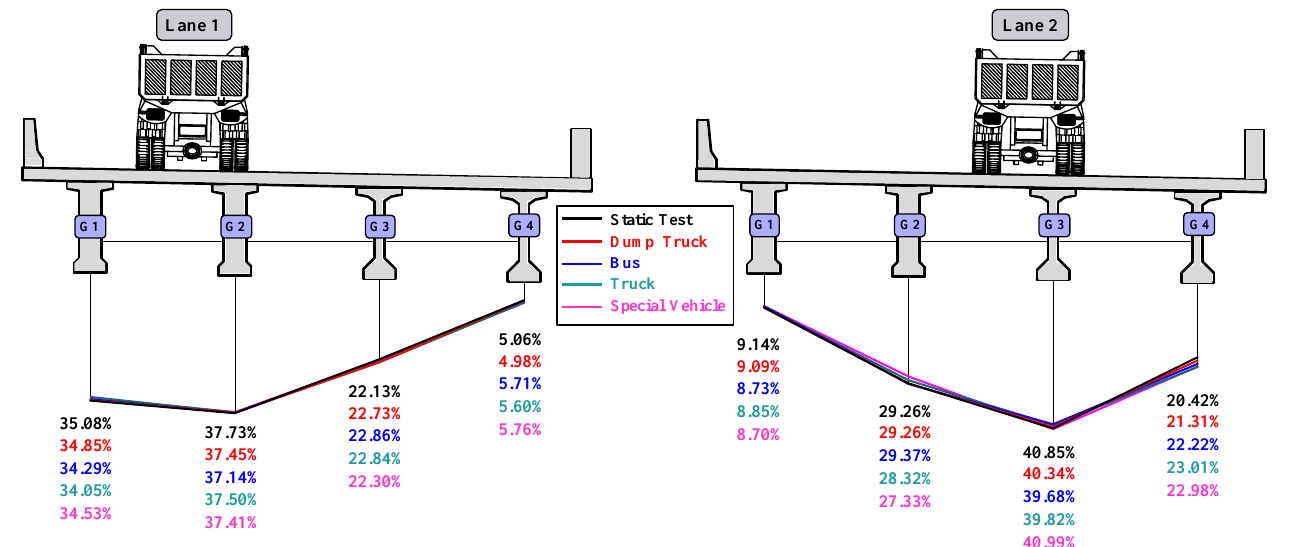
Figure 12. Average LLDF of the bridge according to the vehicle type and lane.